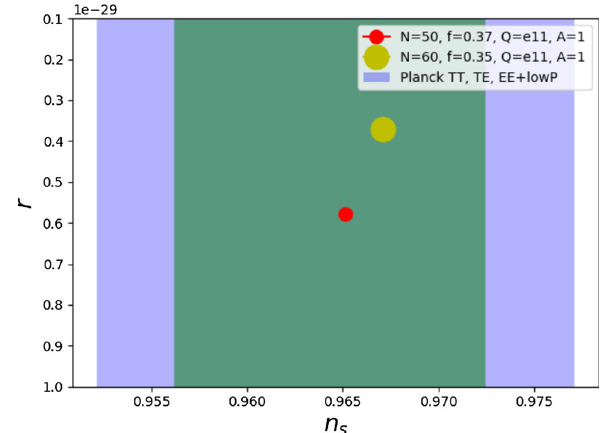
Fig. 2 Extremely Large values of the Q parameter are used to find the model compatible with observation, swampland, and TCC